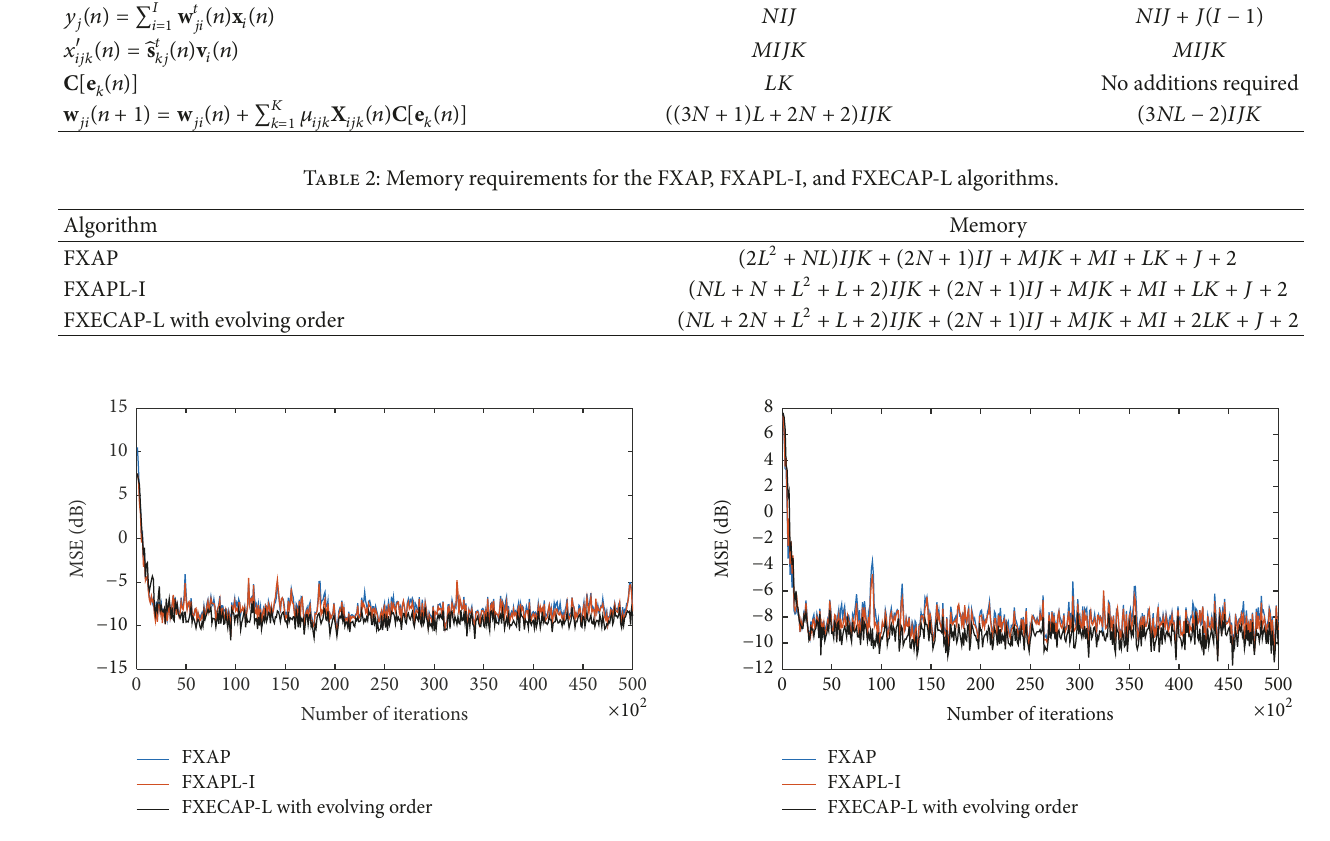
Figure 2: MSE values of the tested AP algorithms for a projection order of 𝐿 = 5 when 𝑏 = 2 bits are used to encode the error.